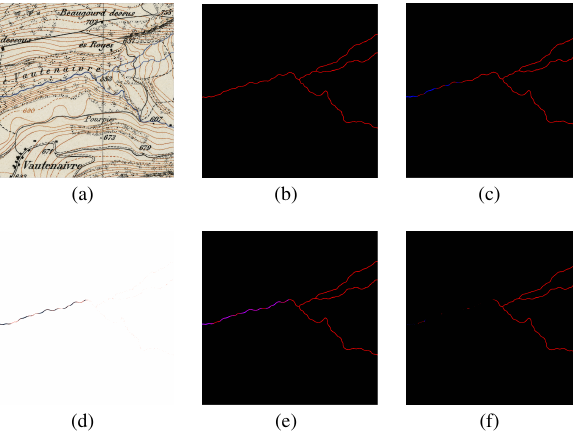
Figure 4. Examples of using the ensemble variance to erode and dilate features. From (a) to (f) are input, ground truth, prediction, variance, dilated prediction and eroded